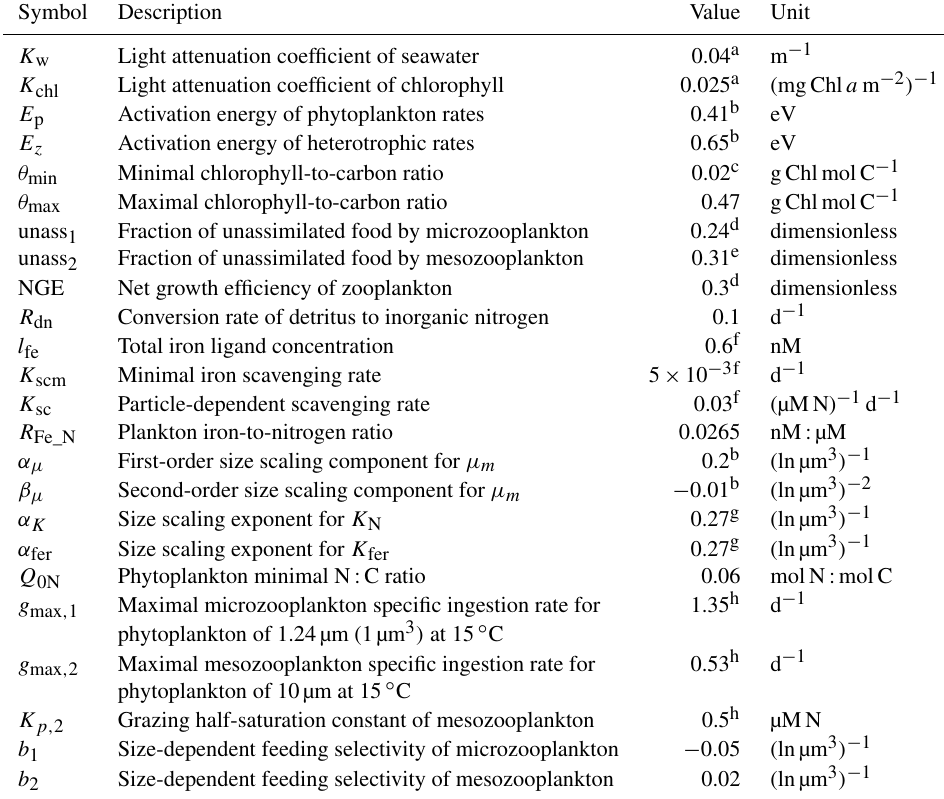
Table 1. Fixed parameters of the CITRATE 1.0 model. Symbol Description K